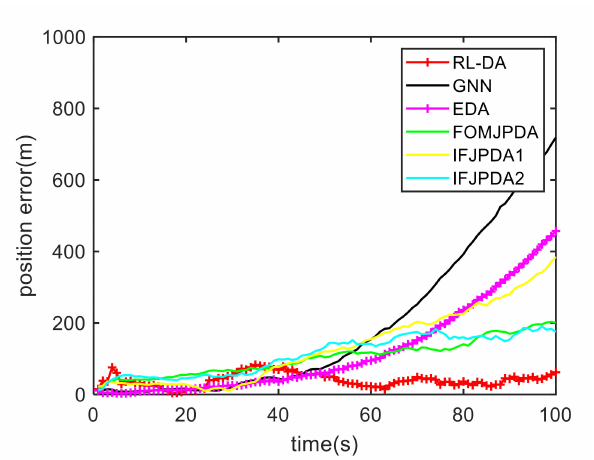
Figure 18. Comparison of the position errors for Target 2 in Case 2.